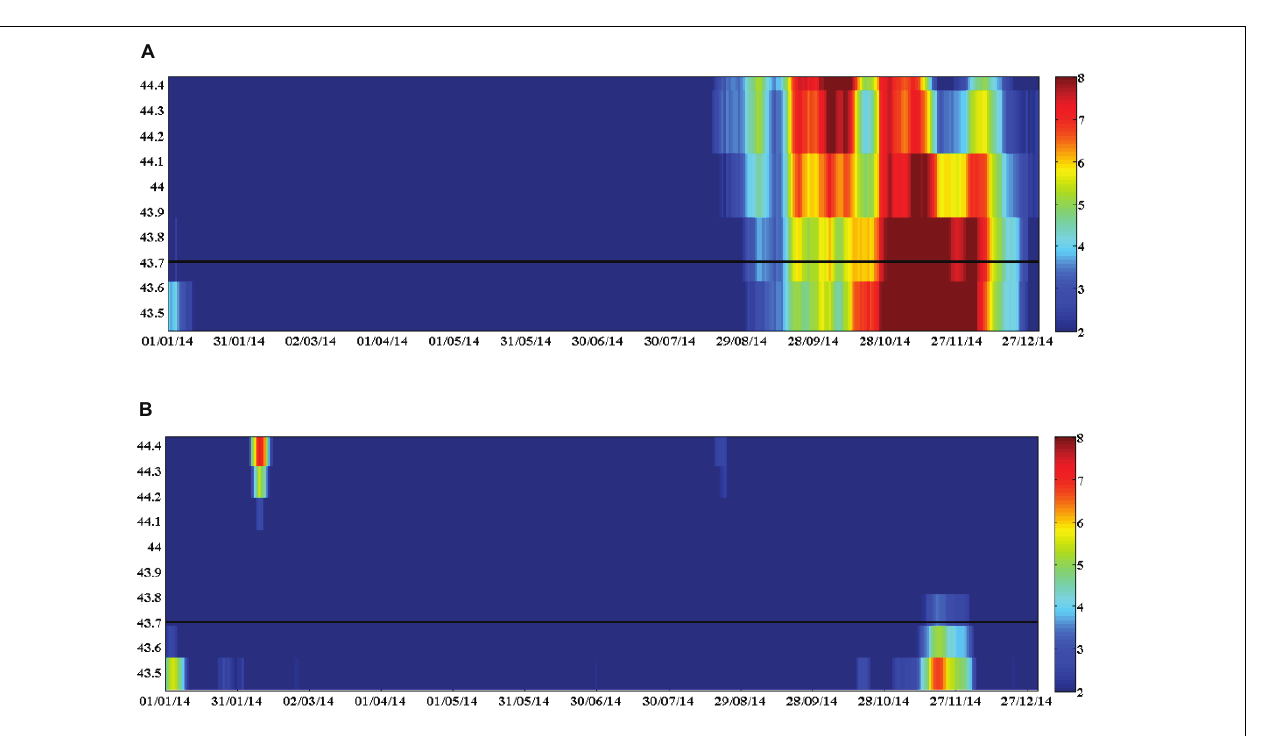
FIGURE 11 | Time evolution of the ADT (cm) along a transect (see the location in Figure 1B ) crossing an area of influence of the IPC (2.44 W), during 2014, computed from the CNES-CLS18 MDT (A) and the Coastal MDT (B) . Note that the spatial mean along the tracks has been removed from the ADT in each position. The black line is the offshore limit (1000 m) of the continental